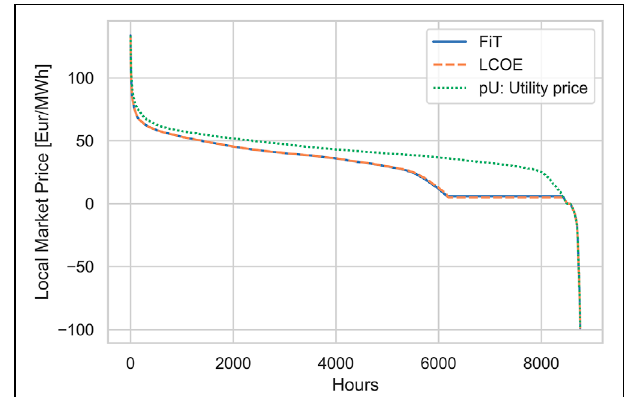
FIGURE 6 | Comparison of LEM price for a day in March obtained for all the simulated scenarios.